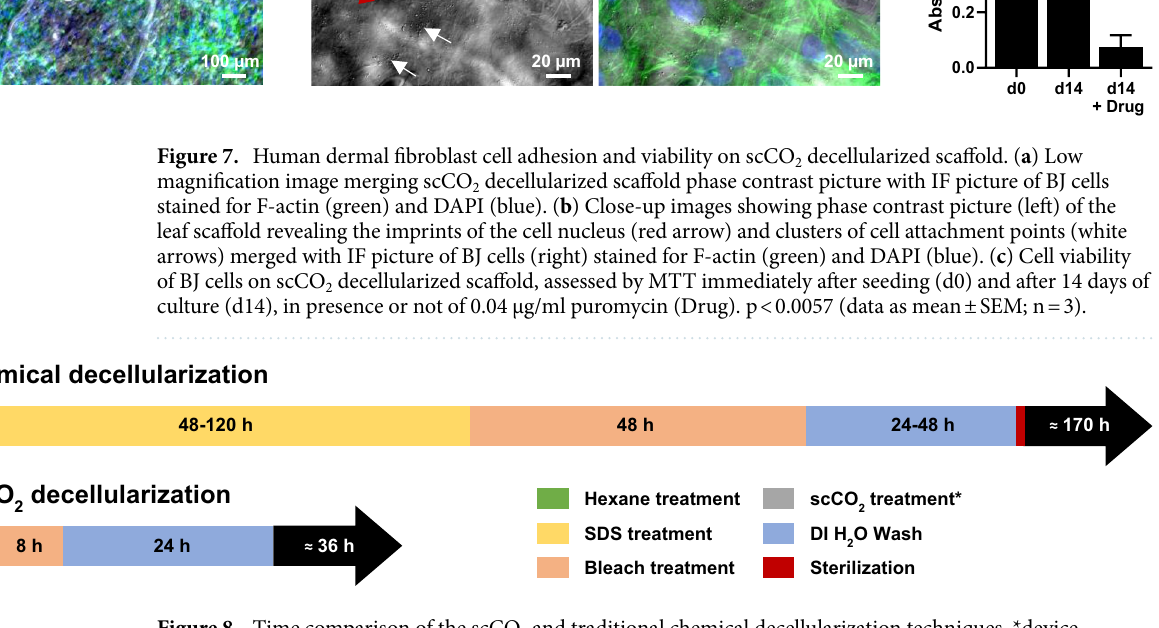
Figure 8. Time comparison of the scCO 2 and traditional chemical decellularization techniques. *device preparation and decompression time